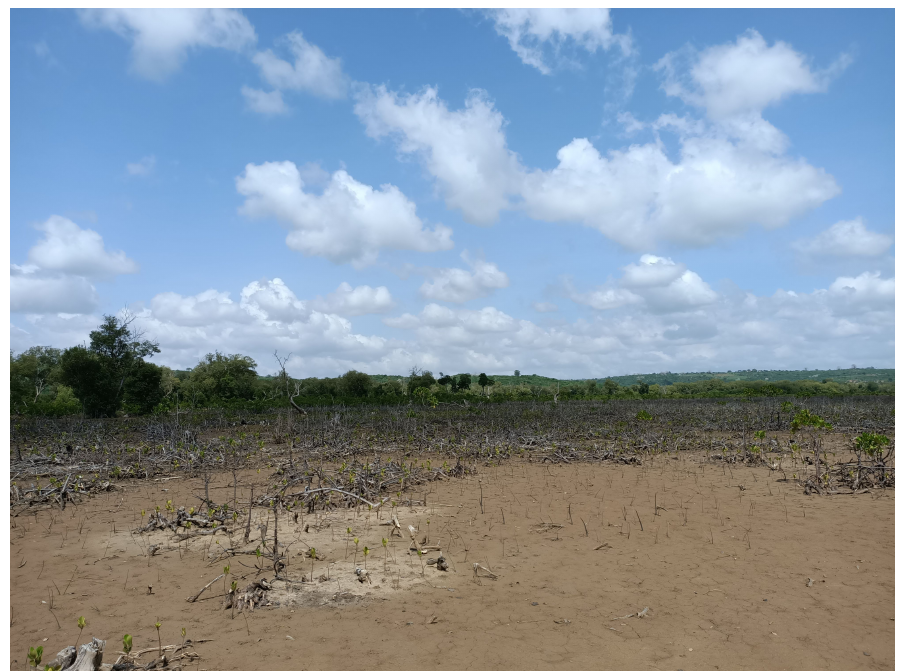
Figure 16. An area of mangroves which has been cut for charcoal production within the region shown in Figure 15. Rehabilitation activities have already started, with the mangrove seeding seen in this photo having been planted as part of that activity. Credit: Wetlands International; Taken: 1 December